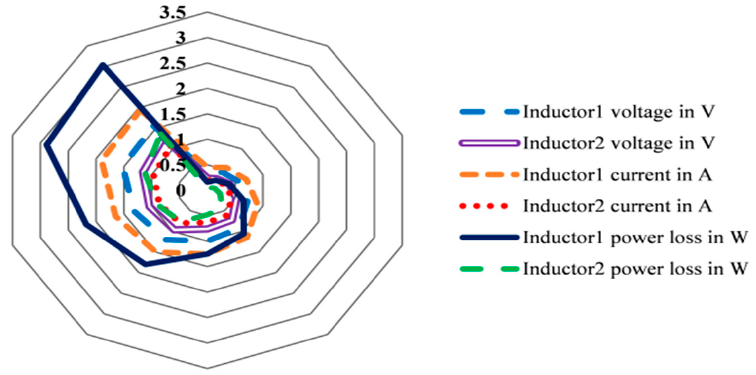
Figure 15. Inductor voltage, current and power loss comparison at f s = 10 kHz and D = 50%.